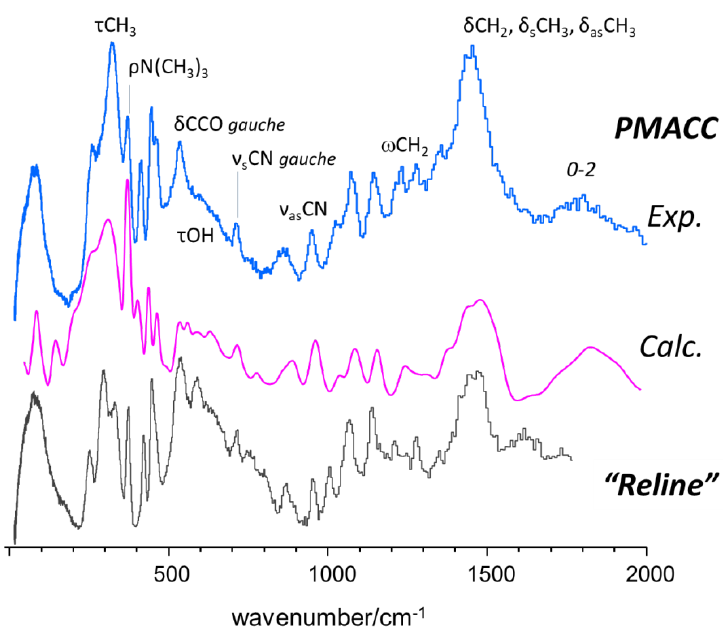
Figure 4. INS spectra of PMACC in the 20–2000 cm − 1 range (top), compared with the calculated spectra from the isotactic triad (middle), and the INS spectrum of reline (bottom) [46] (arbitrary intensity units).